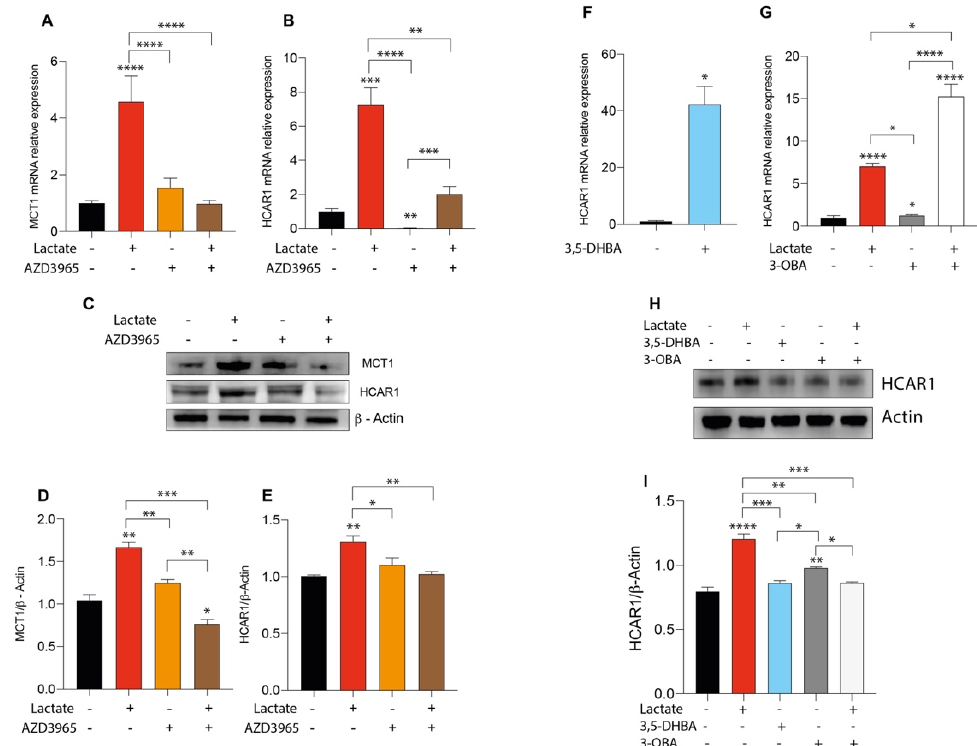
Figure 3. Effect of lactate and 3,5-dihydroxybenzoic acid (3,5-DHBA), AZD3965 and 3-hydroxy-butyrate acid (3-OBA) in expression of monocarboxylate transporter 1 (MCT1) and HCAR1 in uveal melanoma cell line. ( A , B ) MCT1 and HCAR1 mRNA expression levels following 24 h of lactate (20 mM) and AZD3965 (10 μ M) treatment. ( C – E ) MCT1 and HCAR1 protein expression levels following 24 h of lactate (20 mM) and AZD3965 (10 μ M) treatment. ( F , G ) HCAR1 mRNA expression levels following 24 h of 3,5-DHBA (150 μ M), lactate (20 mM), and 3-OBA (3 mM) treatment. ( H , I ) HCAR1 protein expression levels following 24 h of 3,5-DHBA (150 μ M), lactate (20 mM), and 3-OBA (3 mM) treatment. Values represent the mean ± SD of experiments performed in quadruplicate. The figures presented are representative of four independent experiments, and values represent the mean ± SD of experiments performed in quadruplicate (Mann–Whitney U test or two-way ANOVA). * p < 0.05; ** p < 0.01; *** p < 0.001; **** p < 0.0001.